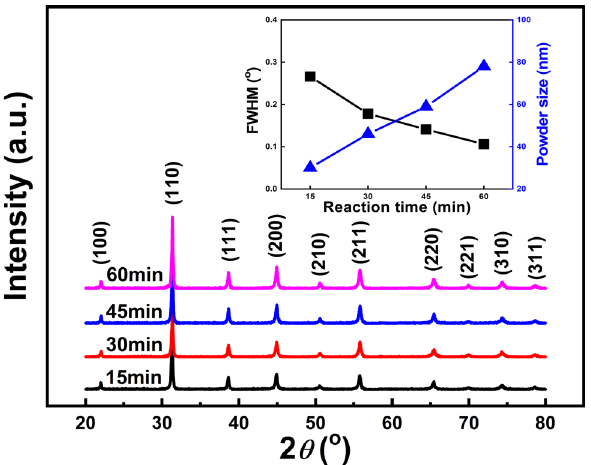
Figure 1. XRD patterns of BCZT powders synthesized at 180 °C for various reaction time [The inset is the FWHM and powder size a function of reaction